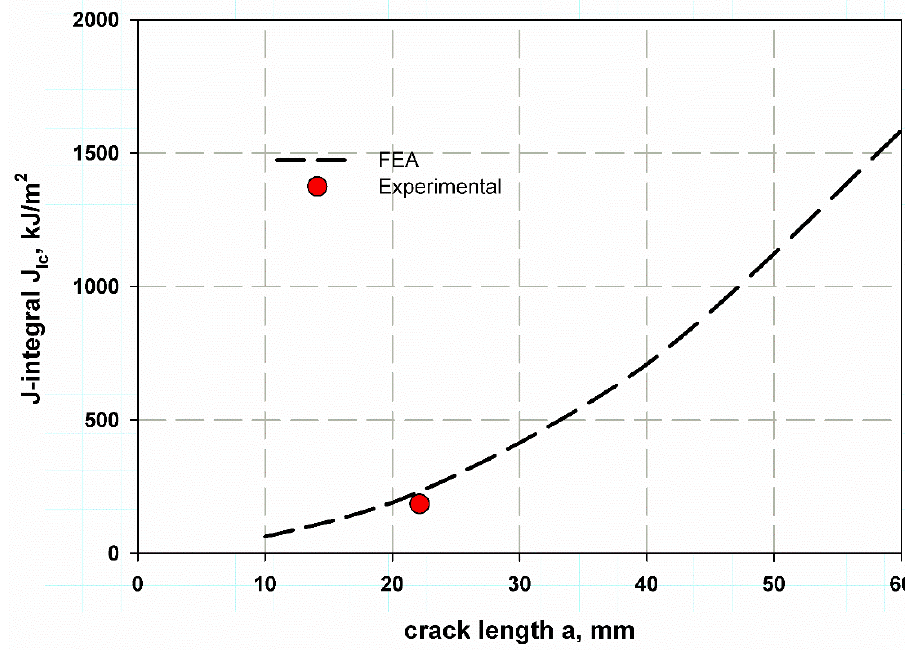
Figure 14. J-integral prediction using XFEM for through-thickness crack of the composite cylinder.